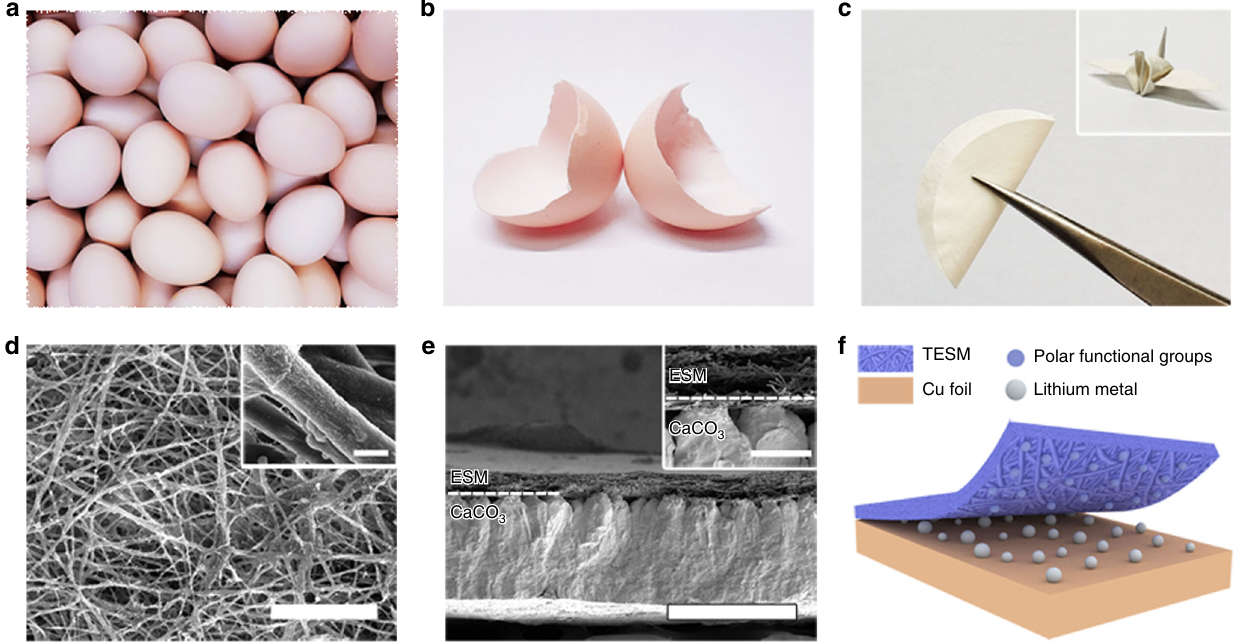
Fig. 1 Schematic diagram of the biomacromolecule matrix employed for Li anodes. a Digital photo of eggs. b Photograph of the collected eggshells. c The bent ESM and corresponding paper cranes folded with it (inset). d SEM images of the ESM and enlarged single protein fi bre. Scale bars, ( d ) 50 μ m and inset 1 μ m. e SEM images of the cross-sectional eggshell and the obvious boundary between the ESM and CaCO 3 shell (inset). Scale bars, ( e ) 400 μ m and inset 50 μ m. f Li growth on TESM-modi fi ed Cu foil. The rich polar functional groups within TESM can regulate the distribution of lithium ions and realize uniform Li